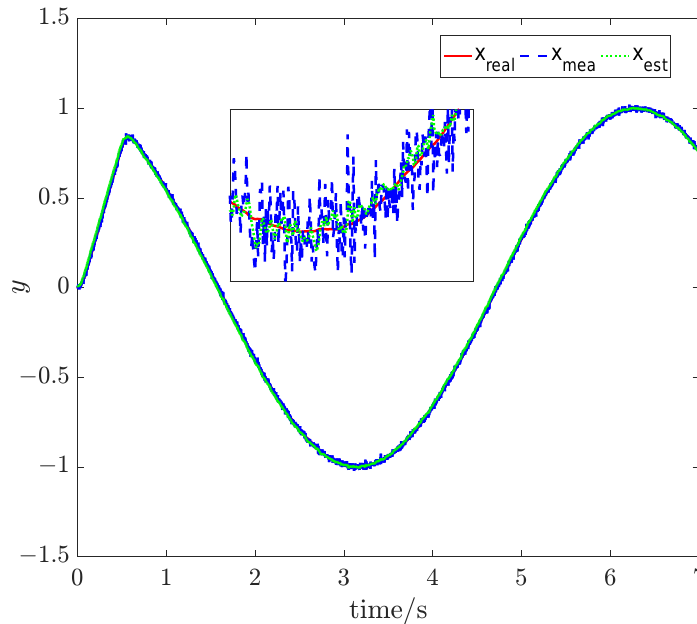
Figure 13. Signal x .